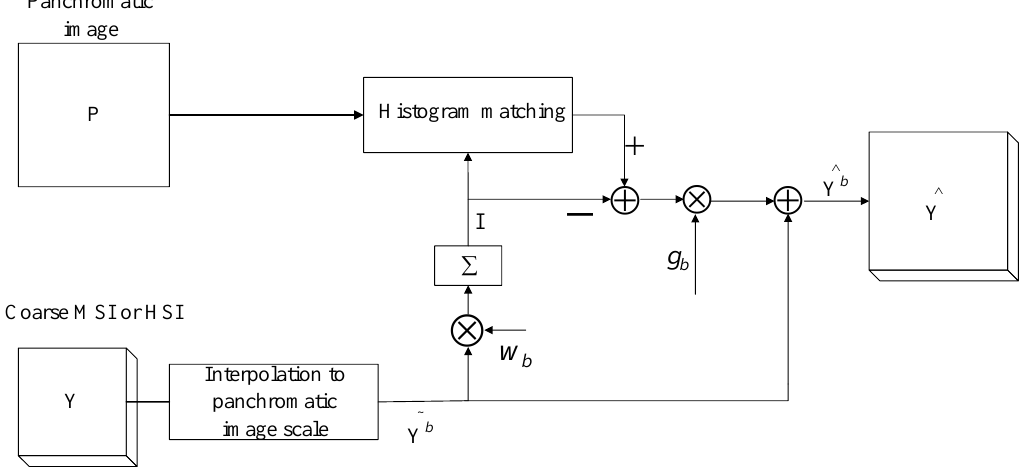
Figure 4. The flowchart of the component substitution (CS) approach.